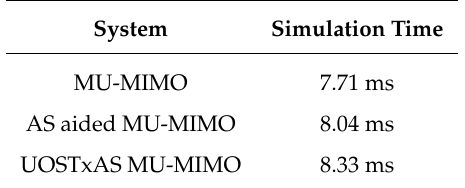
Table 2. Achievable sum capacity simulation time from MATLAB of conventional MU-MIMO without AS, AS aided MU-MIMO, and proposed UOSTxAS MU-MIMO in the case of { K P = 2, K C = 6 } , the